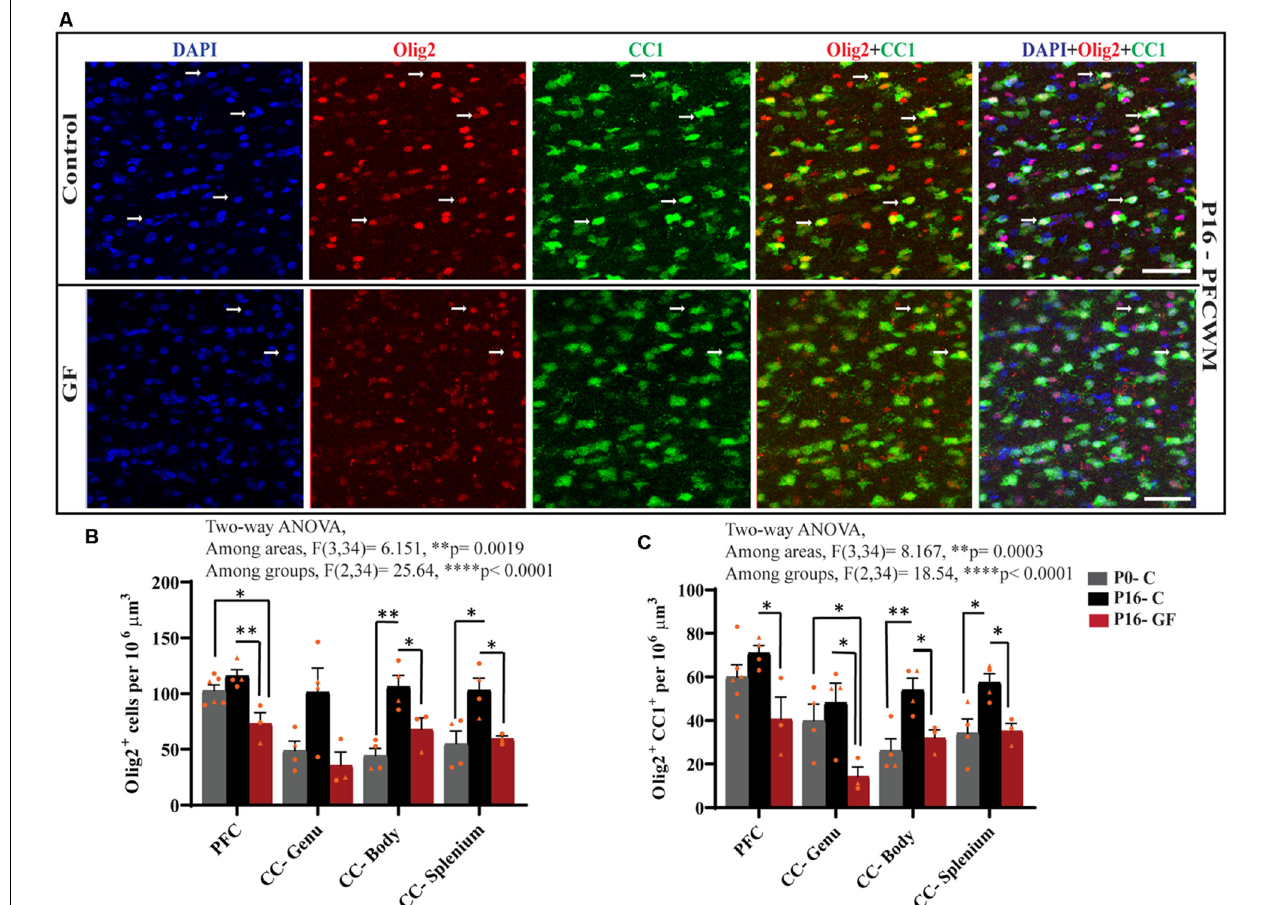
FIGURE 4 | Effects of germ-free conditions on oligodendrocytes and mature oligodendrocytes. (A) Representative images showing all oligodendrocytes (Olig2 + ) and mature oligodendrocytes (Olig2 + CC1 + ) within the PFCWM of control (C) and germ-free (GF) piglets at P16. Scale bar, 50 µ m. White arrows demarcate double positive cells. Quantification of the number of Olig2 + (B) and Olig2 + CC1 + (C) cells in PFCWM, CC-Genu, CC-Body, and CC-Splenium in P0-C, P16-C, and P16-GF animals. Individual male and female animals are marked by orange triangles and circles, respectively. Data expressed as mean ± SEM, n = 3–6 animals/group. ∗∗∗∗ p < 0.0001, two-way ANOVA; ∗ p < 0.05, ∗∗ p < 0.01, unpaired student’s t